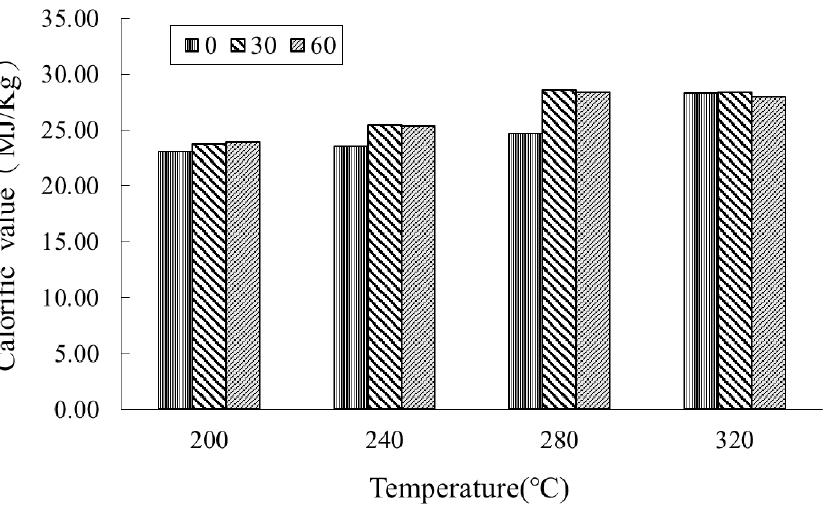
Figure 2. Variations on the calorific values of the SP-torrefied products as a function of the tem- perature (200–360 °C) and residence time (0–60